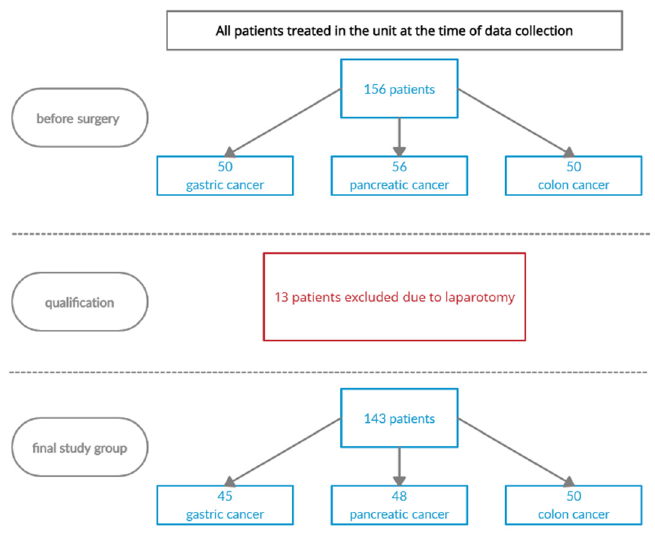
Figure 1. The process of qualifying patients for the study.